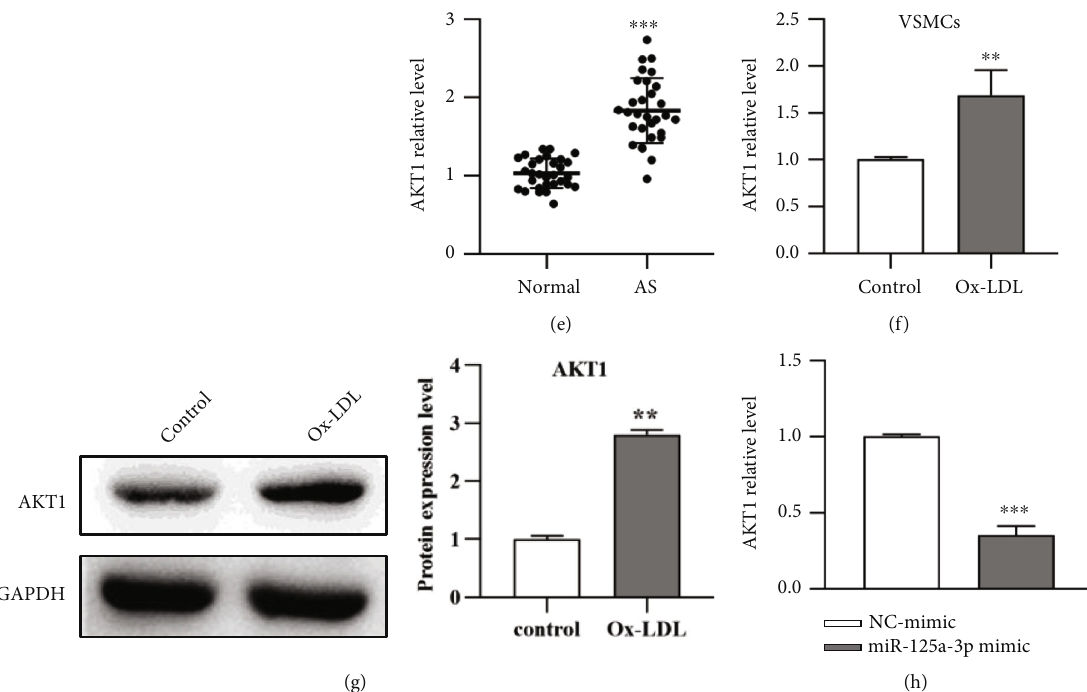
Figure 5: AKT1 is the target of miR-125a-3p. (a) The targets of miR-125a-3p were predicted by miRDB, miRWalk, and TargetScan. (b) Metascape clustering was conducted to screen the targets involved in AS. (c) The binding site of AKT1 and miR-125a-3p was predicted by TargetScan. (d) The targeting relationship between miR-125a-3p and AKT1 was veri fi ed by dual-luciferase reporter assay. (e) The expression of AKT1 in clinical samples was detected by qRT-PCR. The expression of mRNA (f) and protein (g) of AKT1 in Ox-LDL- induced VSMCs was detected by qRT-PCR and western blot, respectively. (h) The expression of AKT1 after transfection with miR-125a- 3p-mimic was detected by qRT-PCR. ** P < 0 : 01 and *** P < 0 : 001